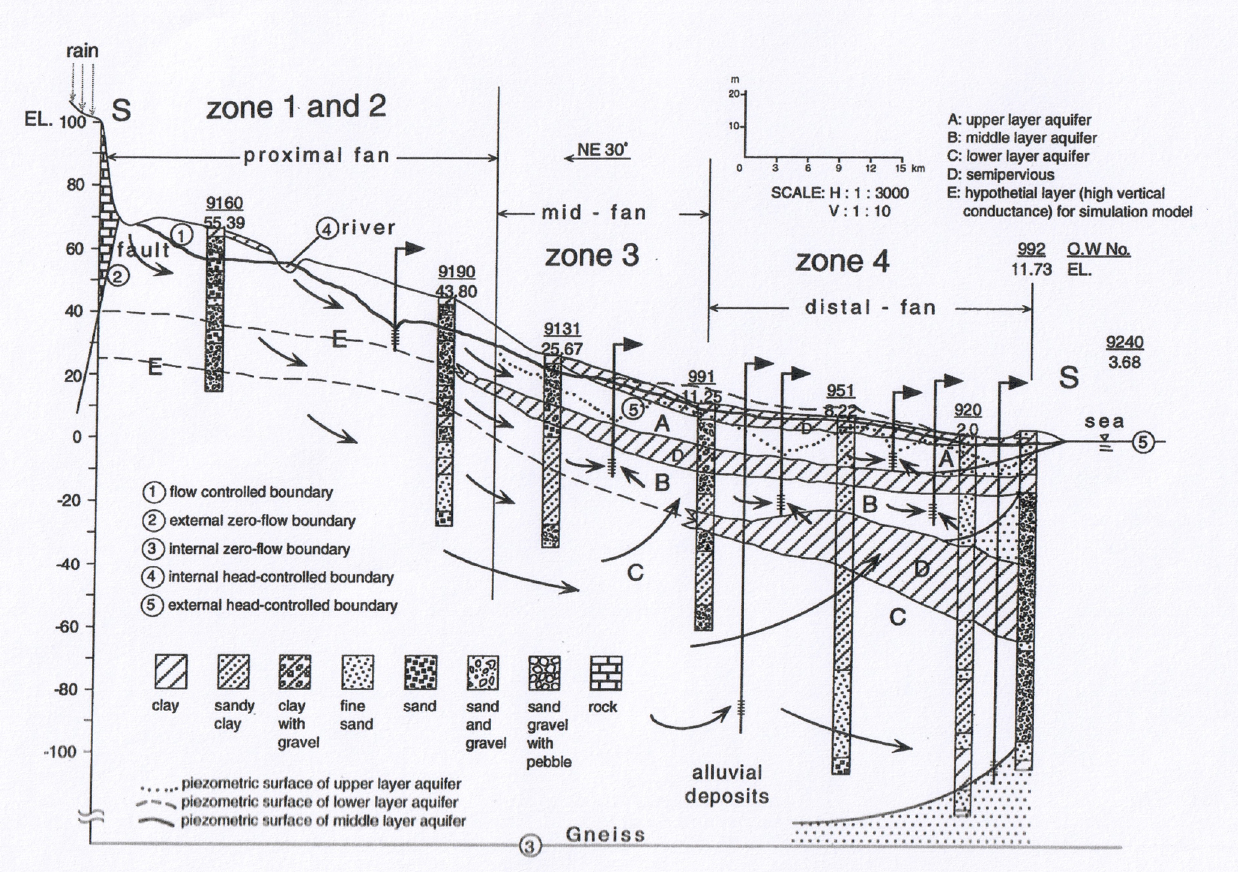
Figure 3. Schematic section of the hydrogeological conceptual model (Ting,